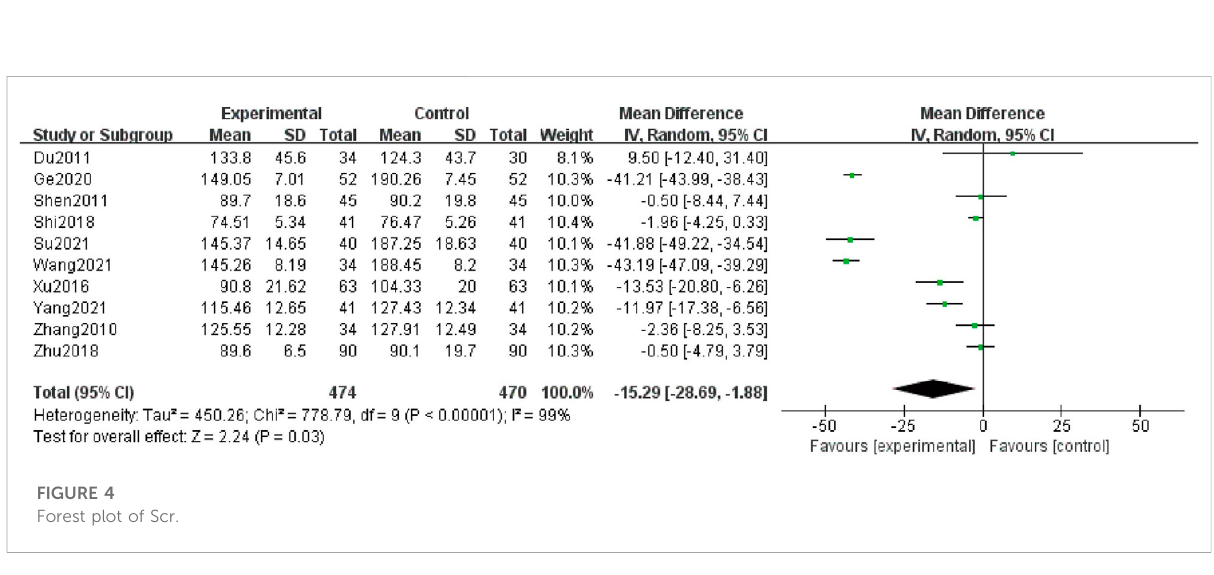
FIGURE 4 Forest plot of Scr.